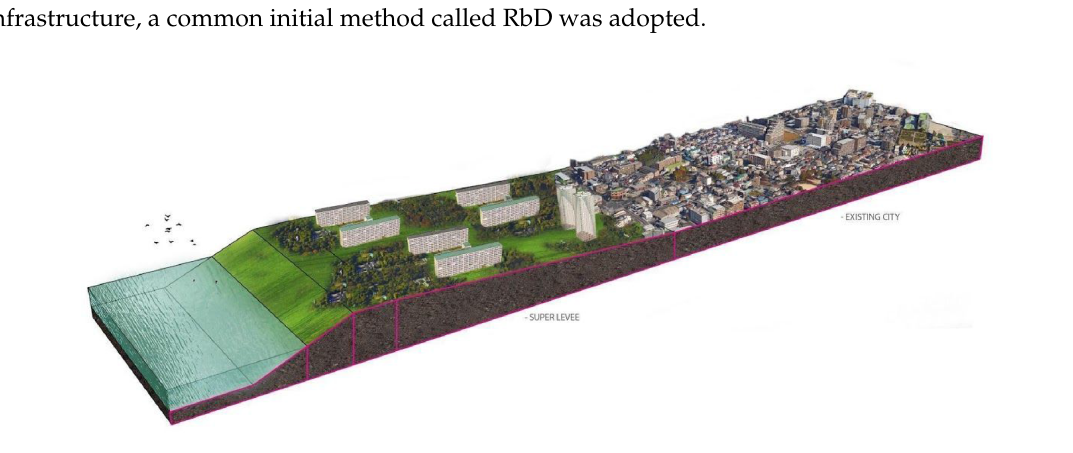
Figure 7. Visualization of the super levee for Edogawa-ku, Tokyo (source: base map from Google Earth and modelled by